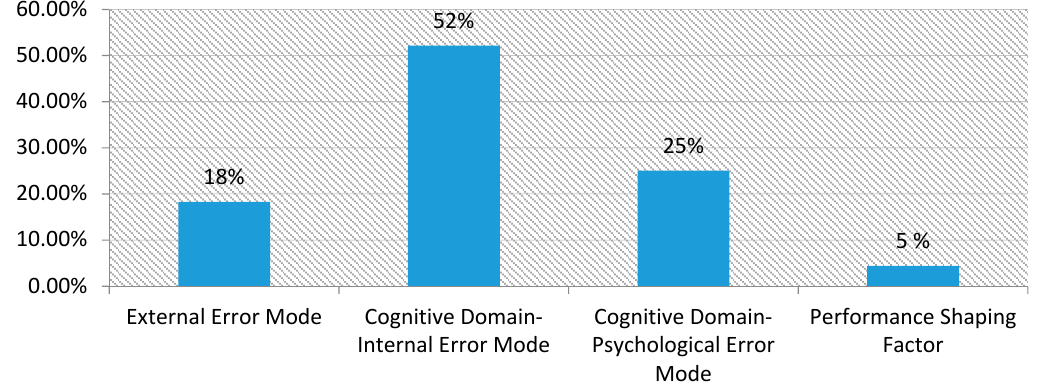
Figure 7. Percentages for the Operators Context.